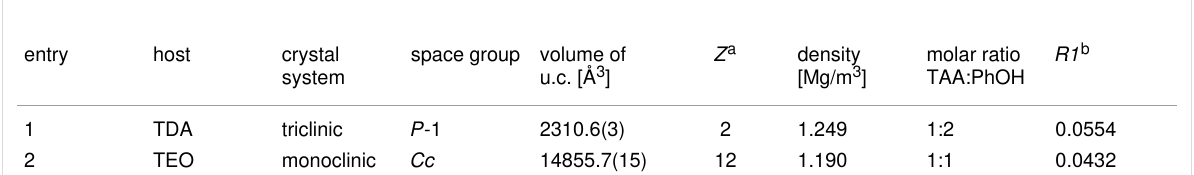
Table 1: Details of crystal structures solved.